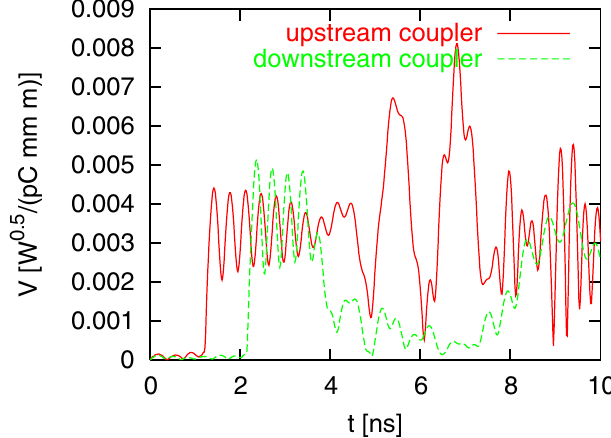
FIG. 10. (Color) Signal envelope from upstream and down- stream monitors vs